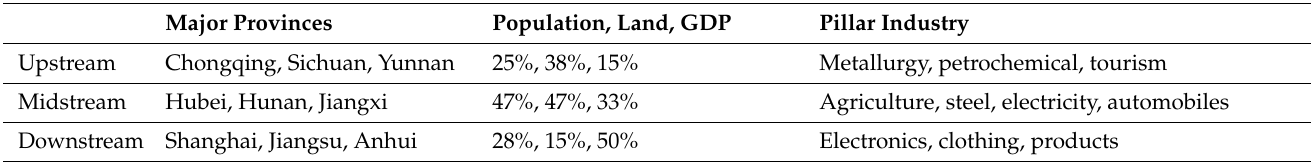
Table 7. The distribution of indicators in the upper, middle, and lower reaches of the Yangtze River. Major Provinces Population, Land,